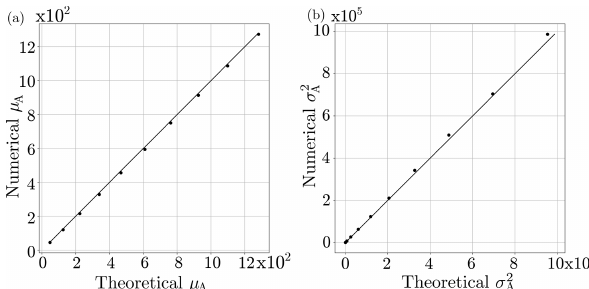
Figure 5. Plots of theoretical versus numerical values for µ A ( l ) (a) and σ 2 ( l ) (b) . The 1 : 1 line is shown in A